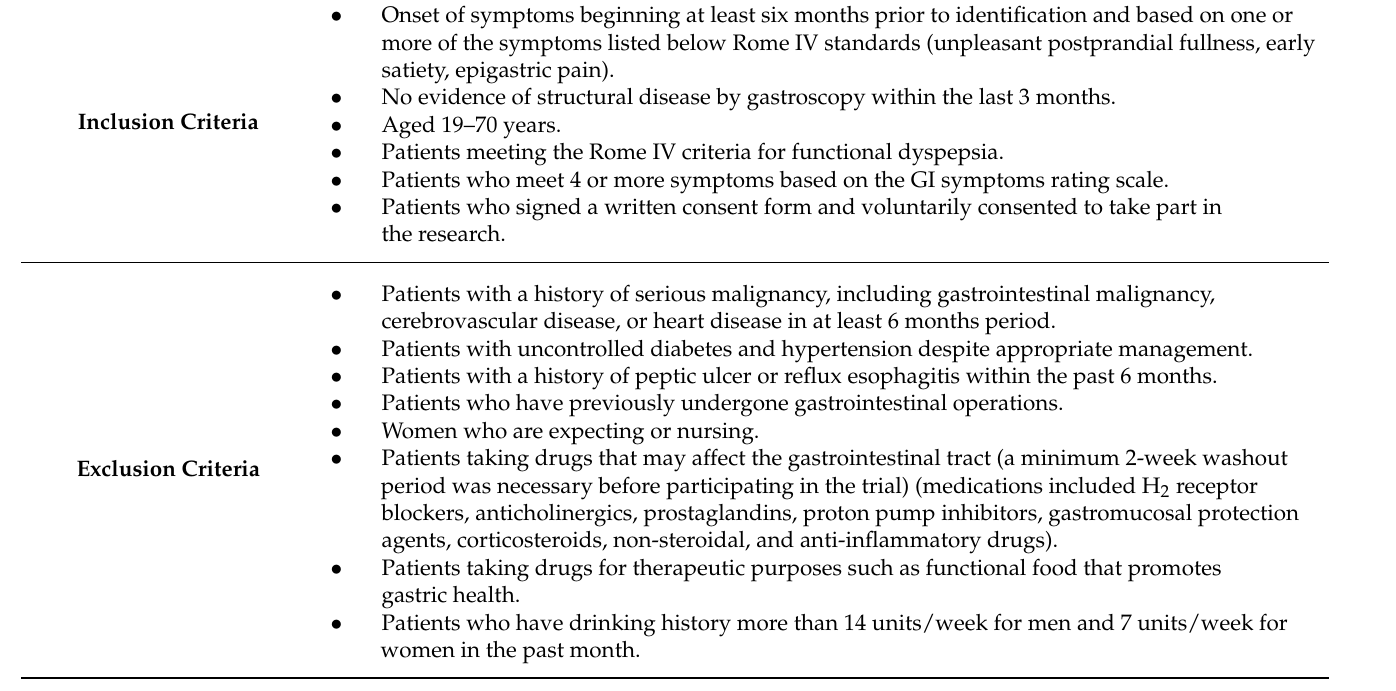
Table 1. Inclusion and exclusion criteria for